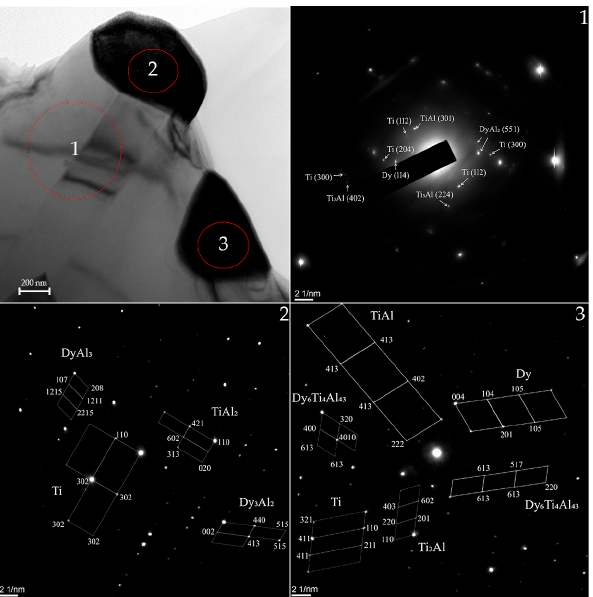
Figure 5. TEM patterns of the TAD alloy, selected area electron diffraction (SAED) patterns of the TAD alloy in the relevant region (1)–(3). A detailed analysis of the TAH specimen showed the presence of dislocations on the surface (Figure 6). In this way, phases TiAl 2 (712), Ti 3 Al (004), Ho (114) Ho (203), HoAl 3 (2215), HoAl 2 (551) were identified in the surface composition of the spectral region (1). The authors think that the formation of dislocations is associated with the product crys- tallization. In the process of which the formation of dispersed particles and lamellar struc- tures occurs that causes stress and increased defectiveness of the alloy. Analysis in